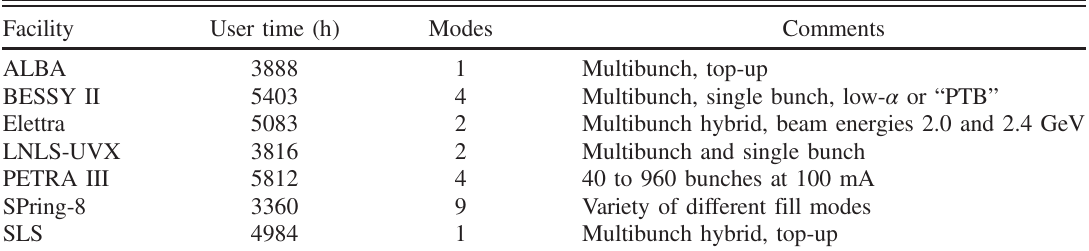
TABLE I. Overview of operation in 2014 (PETRA III numbers for 2013, since 2014 was shut